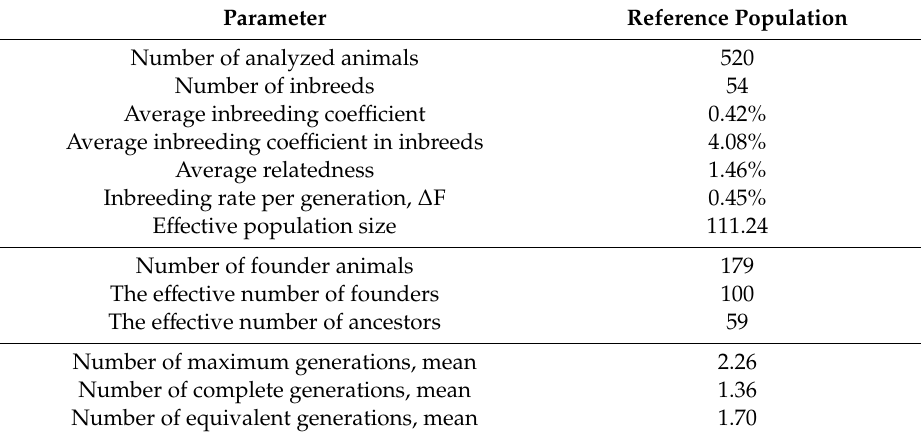
Table 2. Results of pedigree analysis for the reference population of the Istrian shorthaired hound.